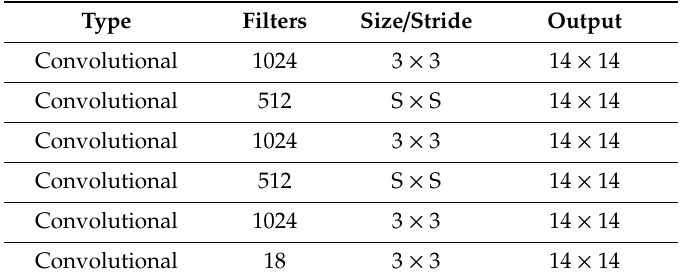
Table 2. Configuration of TSBBR for tiny objects.